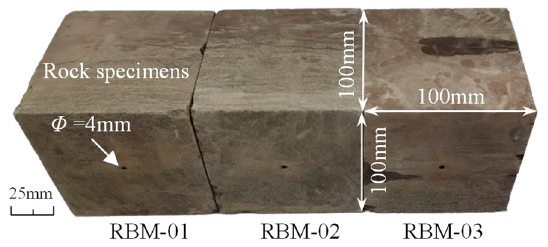
Figure 5. Machining and experimental preparation of the cubic mudstone specimens. Table 1. Parameters of the Self-Priming Pump.